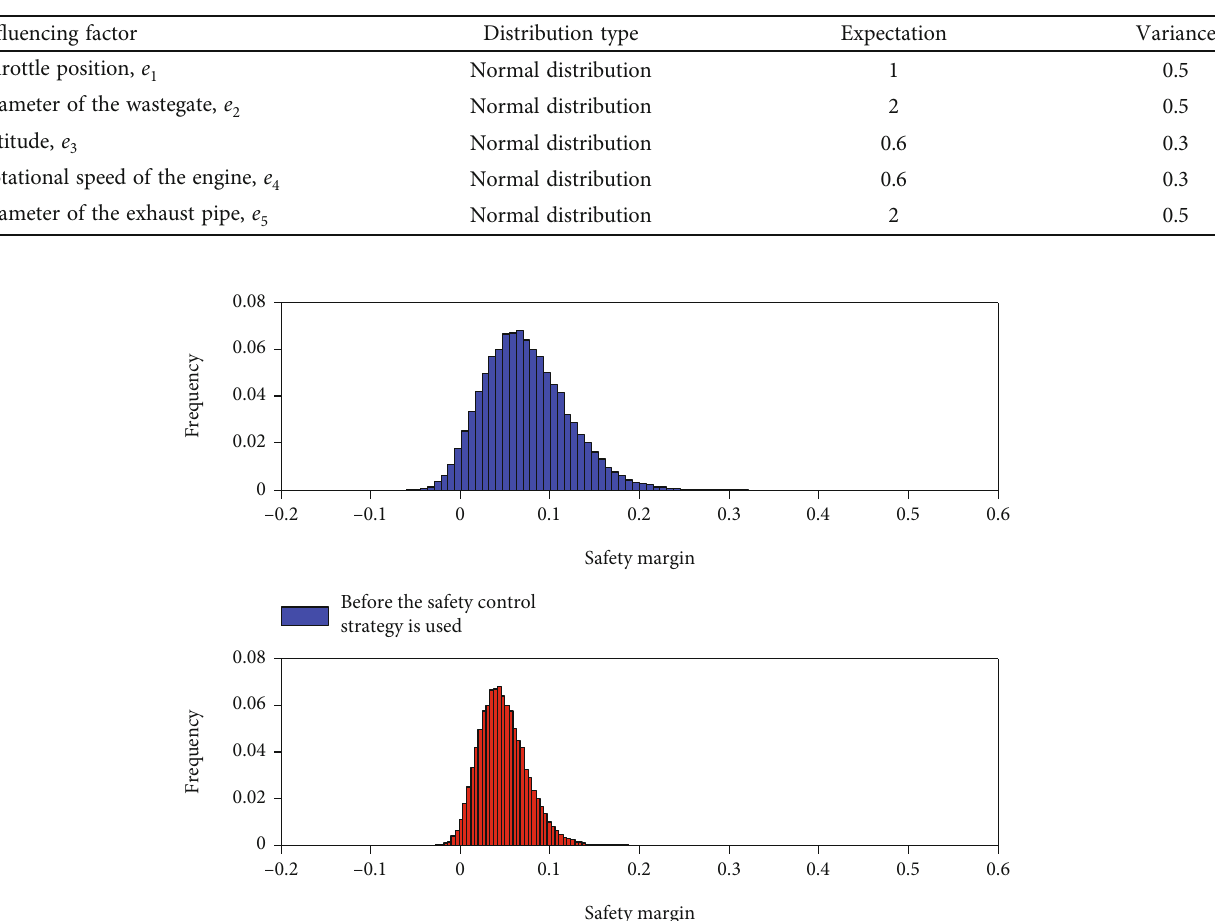
Table 5: Probability distribution characteristics and related parameters of in fl uencing factors (normalized).